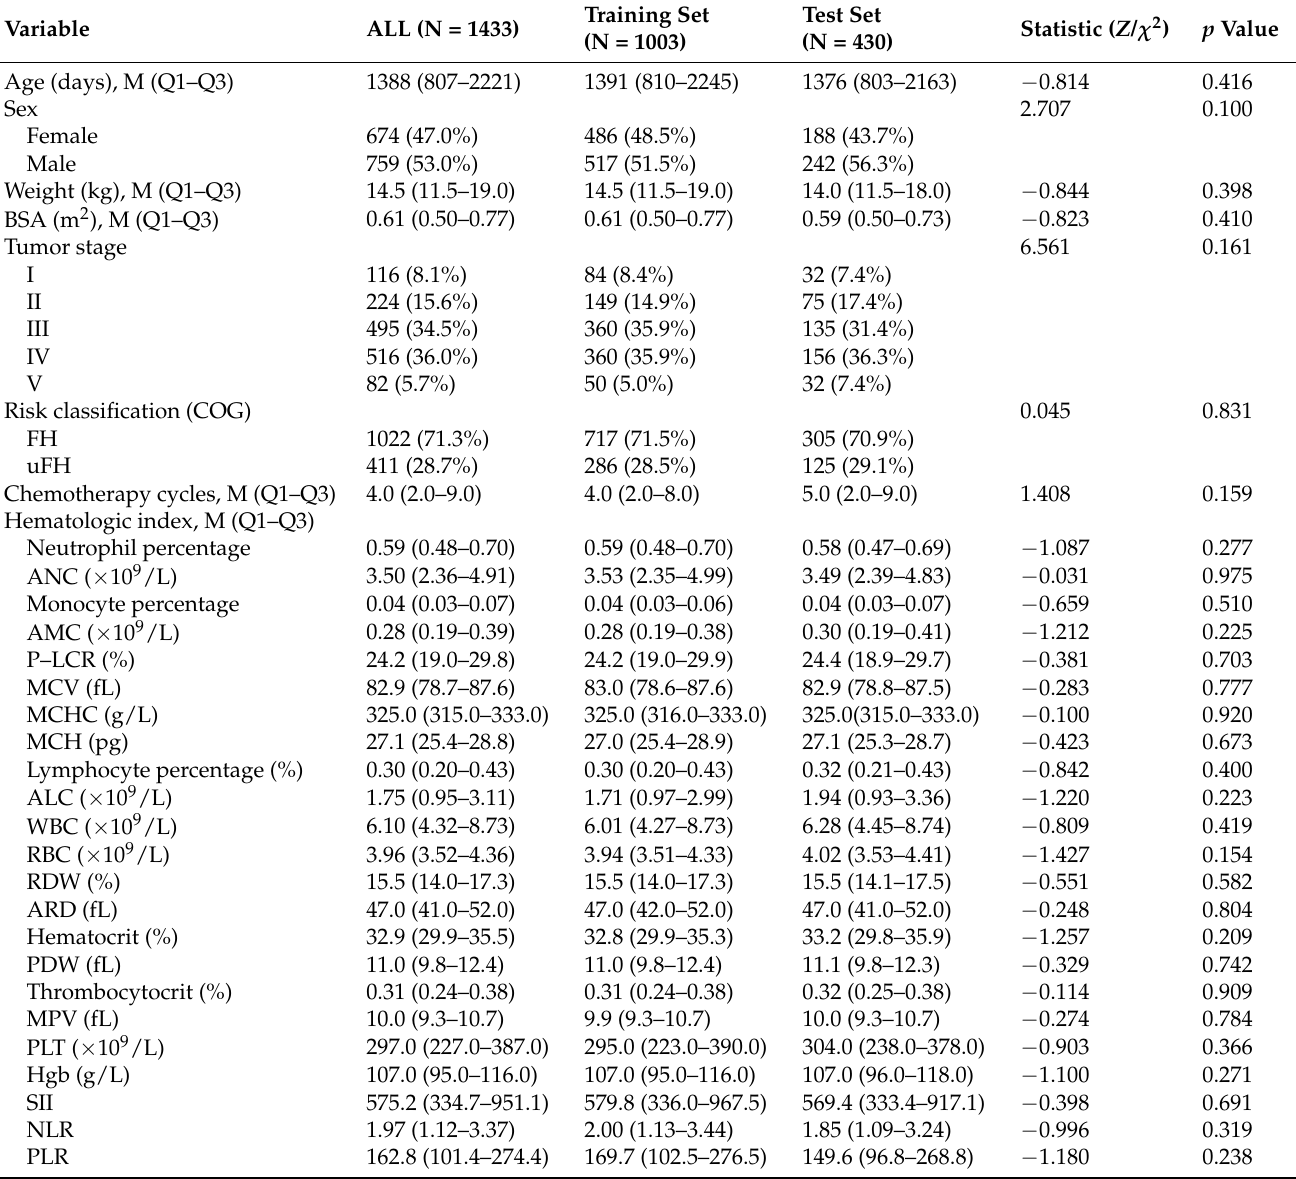
Table 1. Comparison of baseline characteristics of patients in different data